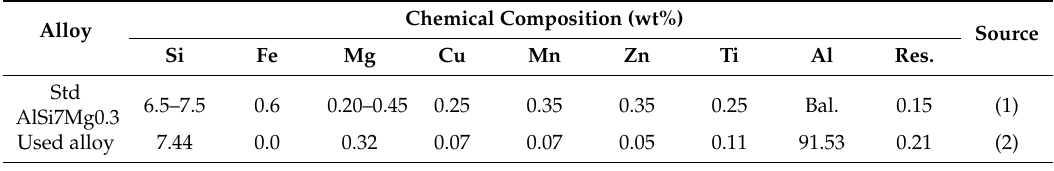
Table 1. Chemical composition of standard AlSi7Mg0.3